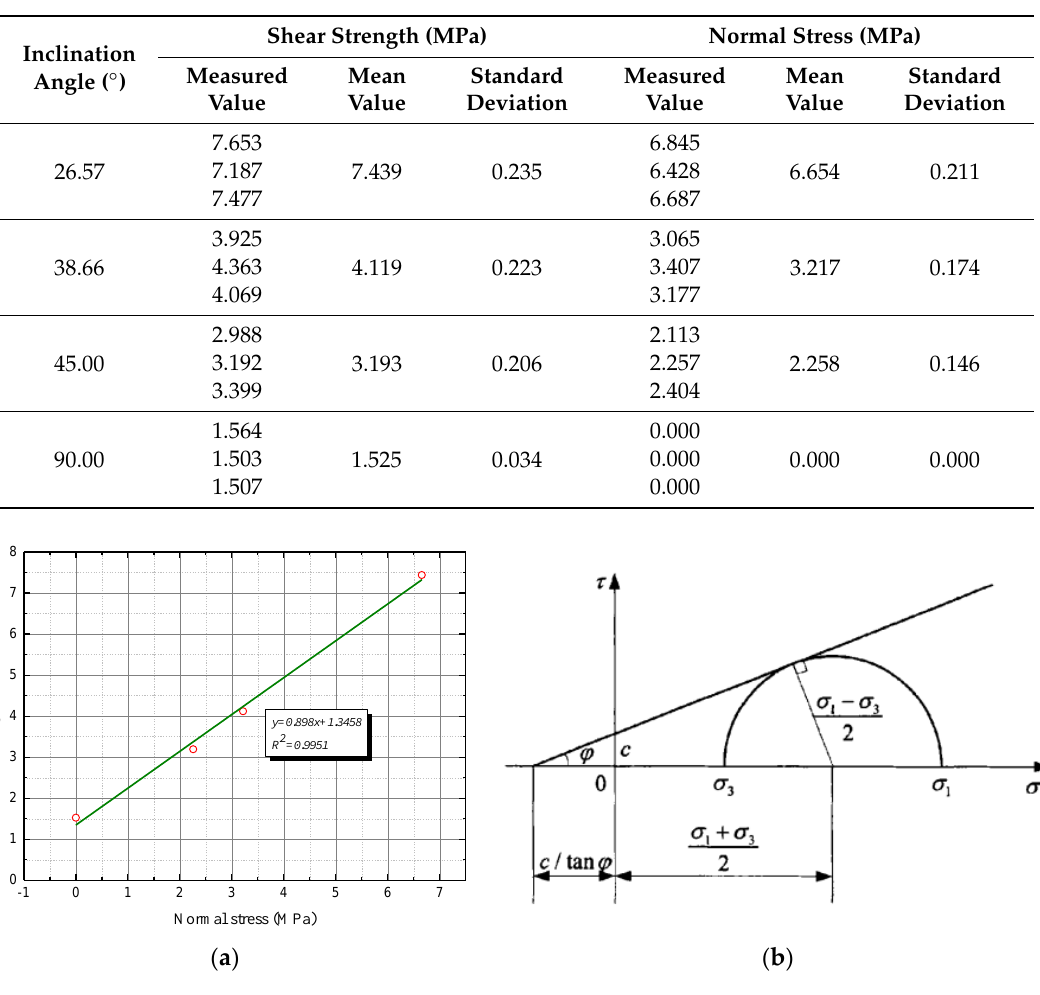
Figure 13. Shear test results: (a) Interfacial failure criterion, (b) Mohr–Coulomb criterion.